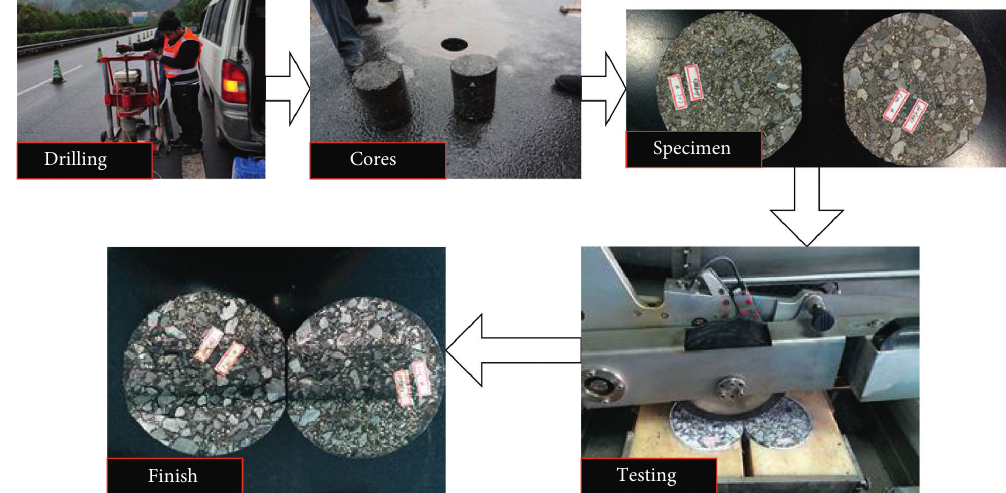
Figure 3: HWTT process of the field cores.